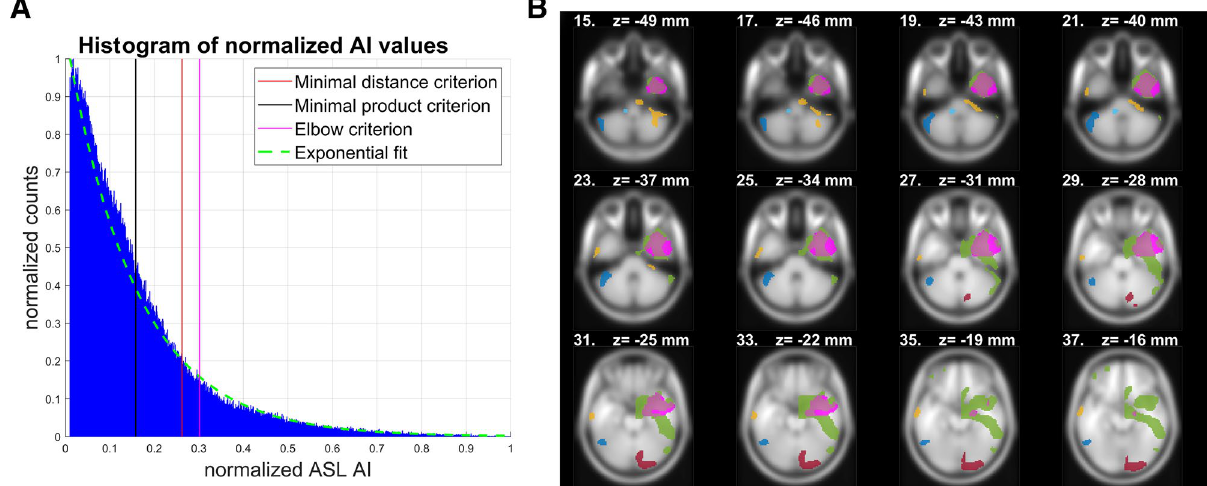
Figure 1. Example of AI (A) histogram of a representative subject from the POST group. Adaptive thresholds are depicted, based on the three proposed thresholding methods. On the right (B) is a slice view with a resection mask (magenta) and clusters (other colors) of AI after thresholding with the minimal product criterion. This was revealed to be the optimal criterion. Used abbreviations: AI—asymmetry index, ASL—arterial spin